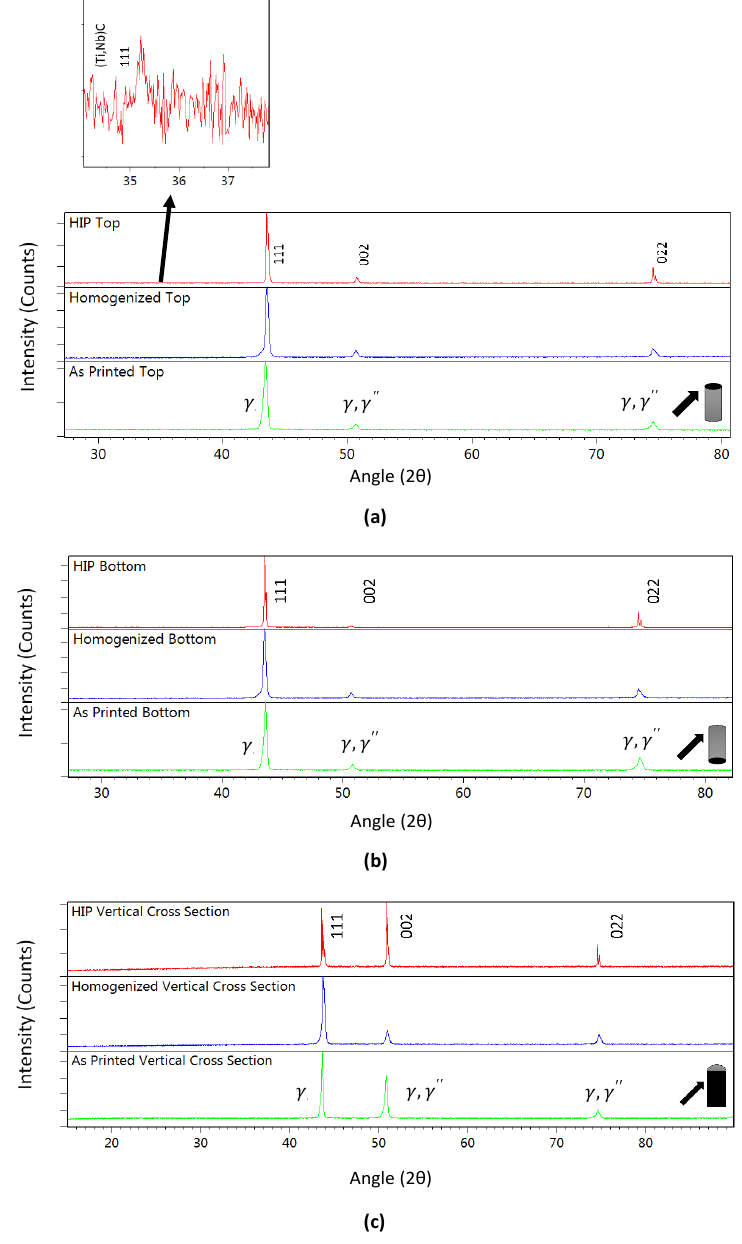
Figure 10. XRD spectra of the ( a ) top horizontal cross-section, ( b ) bottom horizontal cross-section, and ( c ) vertical cross-section of the as-printed, homogenized, and HIP-treated specimens.